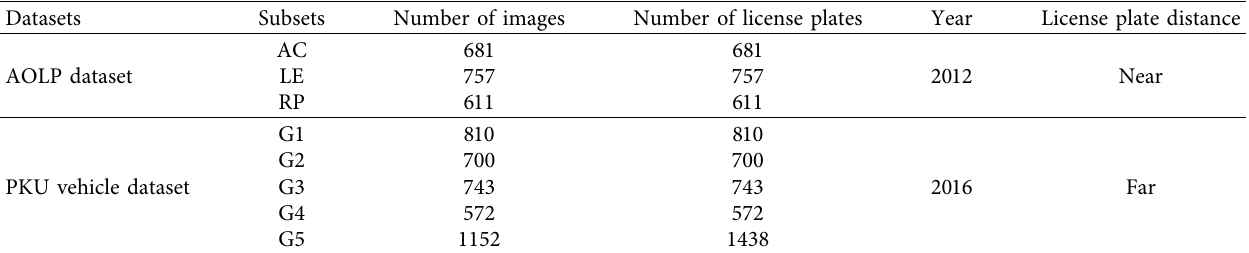
Table 3: The summary of license plate datasets used in this paper.